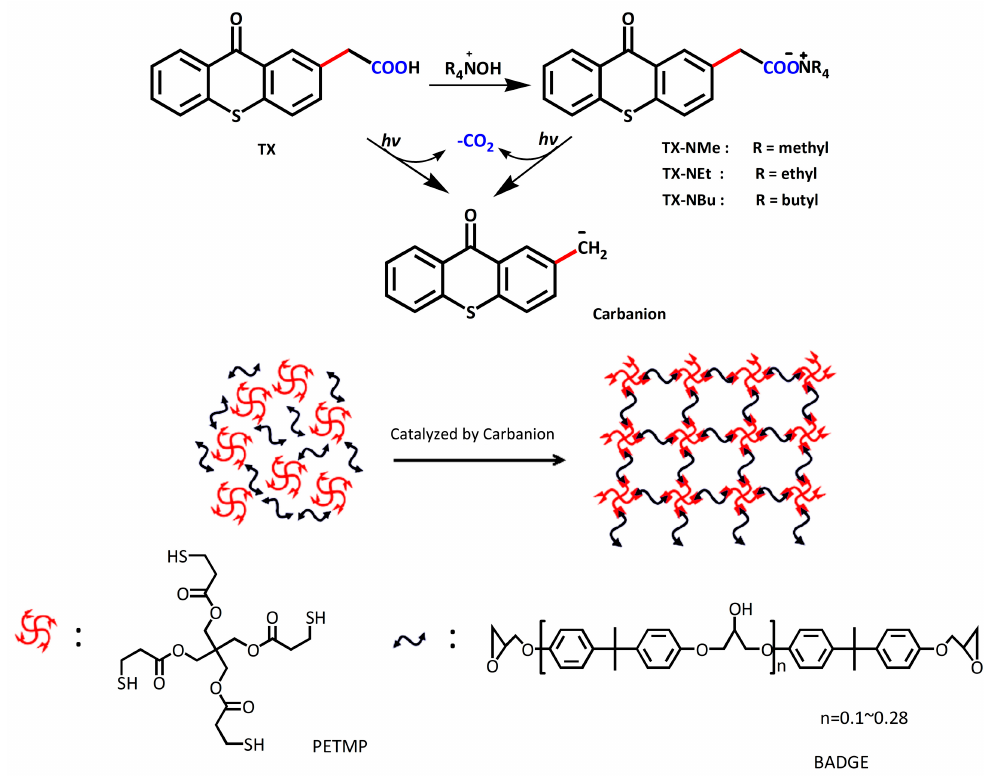
Figure 1. Structures of the PBGs designed to generate carbanion and their application in thiol–epoxy polymerization.